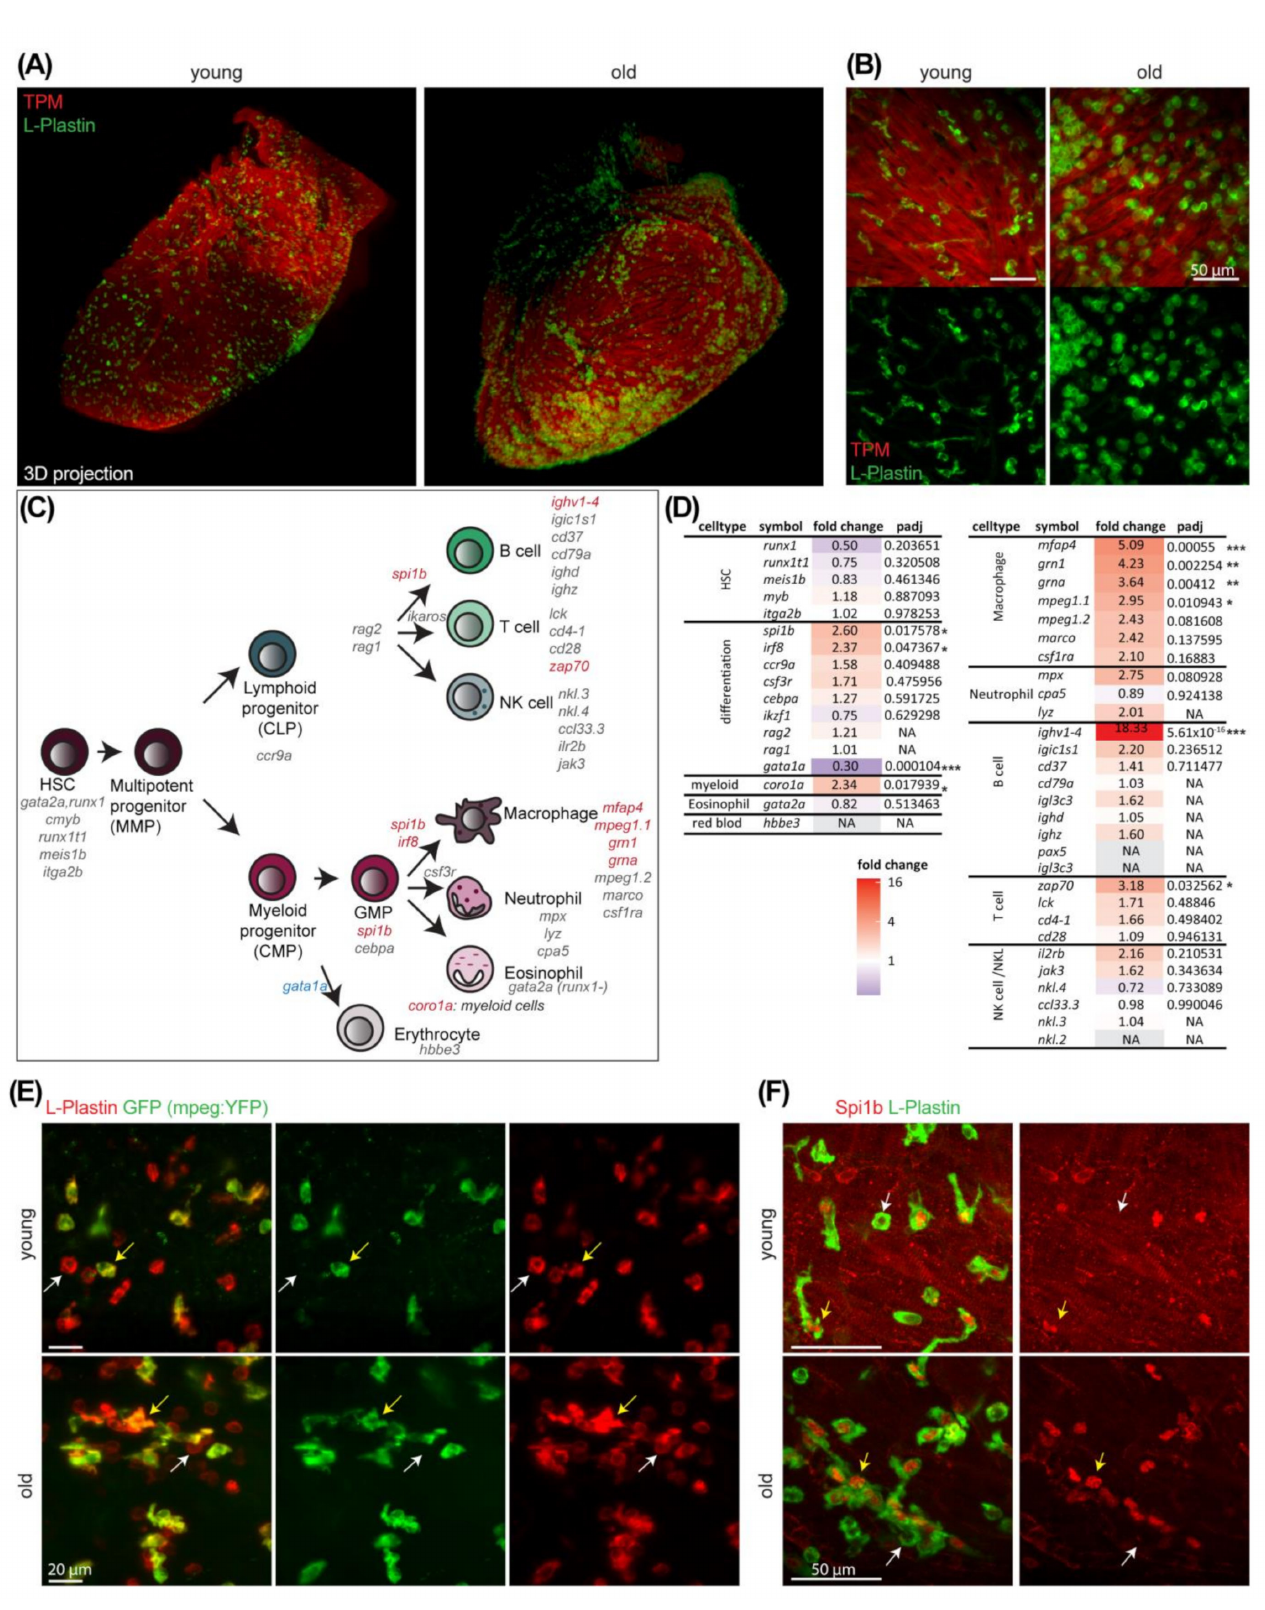
Figure 4. Immune cells accumulate in ventricles upon aging. ( A ) Whole-mount immunostaining of old (4 years) and young (1 year) fish hearts for the pan-leukocyte marker L-Plastin (green) and the muscle marker Tropomyosin (TPM) (red) are shown. Lightsheet microscopy and 3D projection reveal increased cell numbers and cell cluster formation in old hearts. ( B ) Higher magnification images